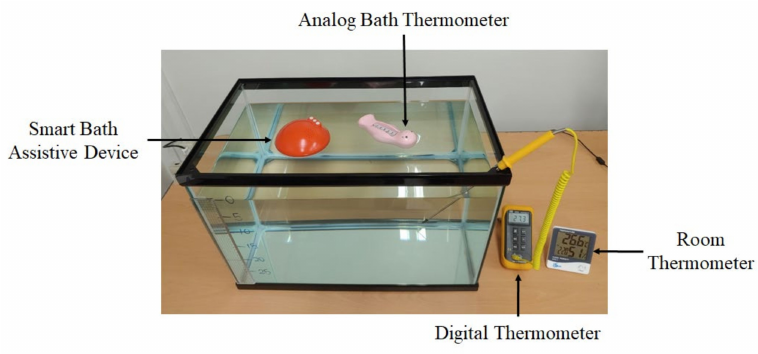
Figure 7. Experiment for comparison of the proposed system with a commercial analog bath thermometer.